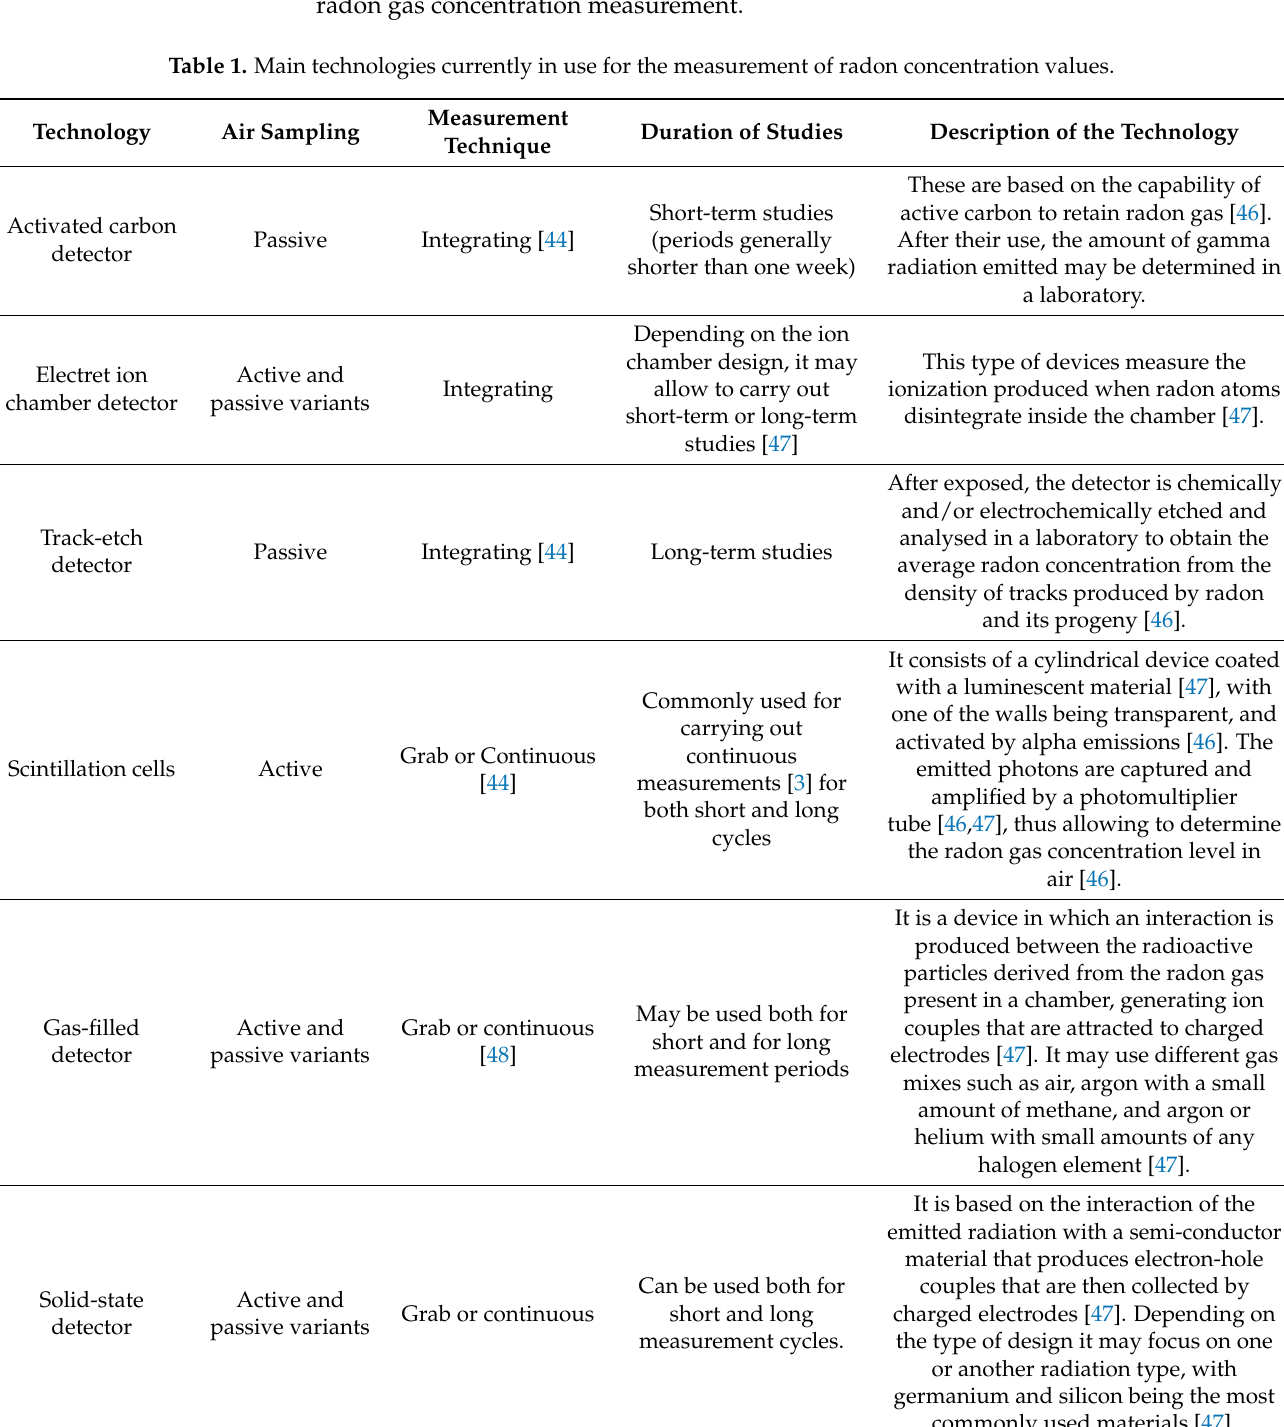
Table 1. Main technologies currently in use for the measurement of radon concentration